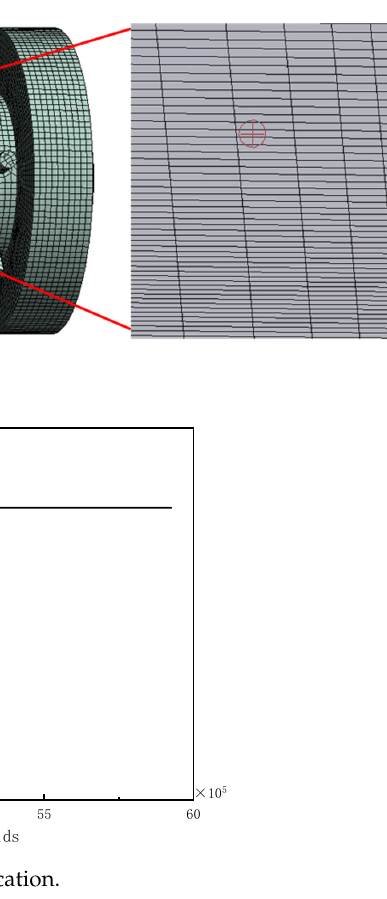
Figure 5. Fluid 3D model.